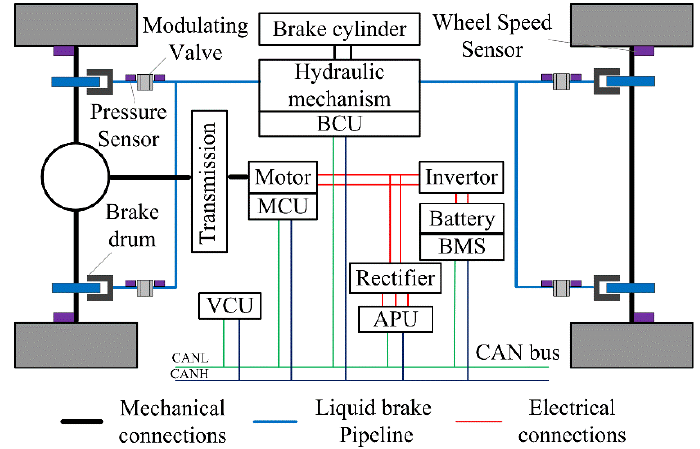
Figure 1. Structure of the range-extended electric vehicle (R-EEV) with the regenerative braking system.